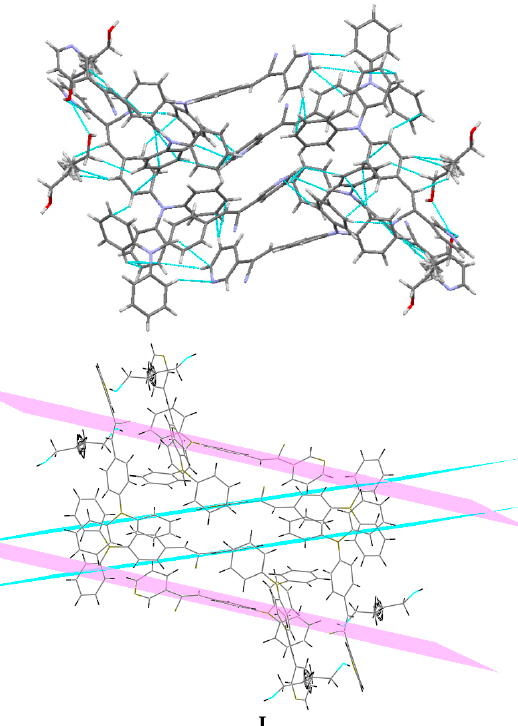
Figure 7. Cont. Figure 7.